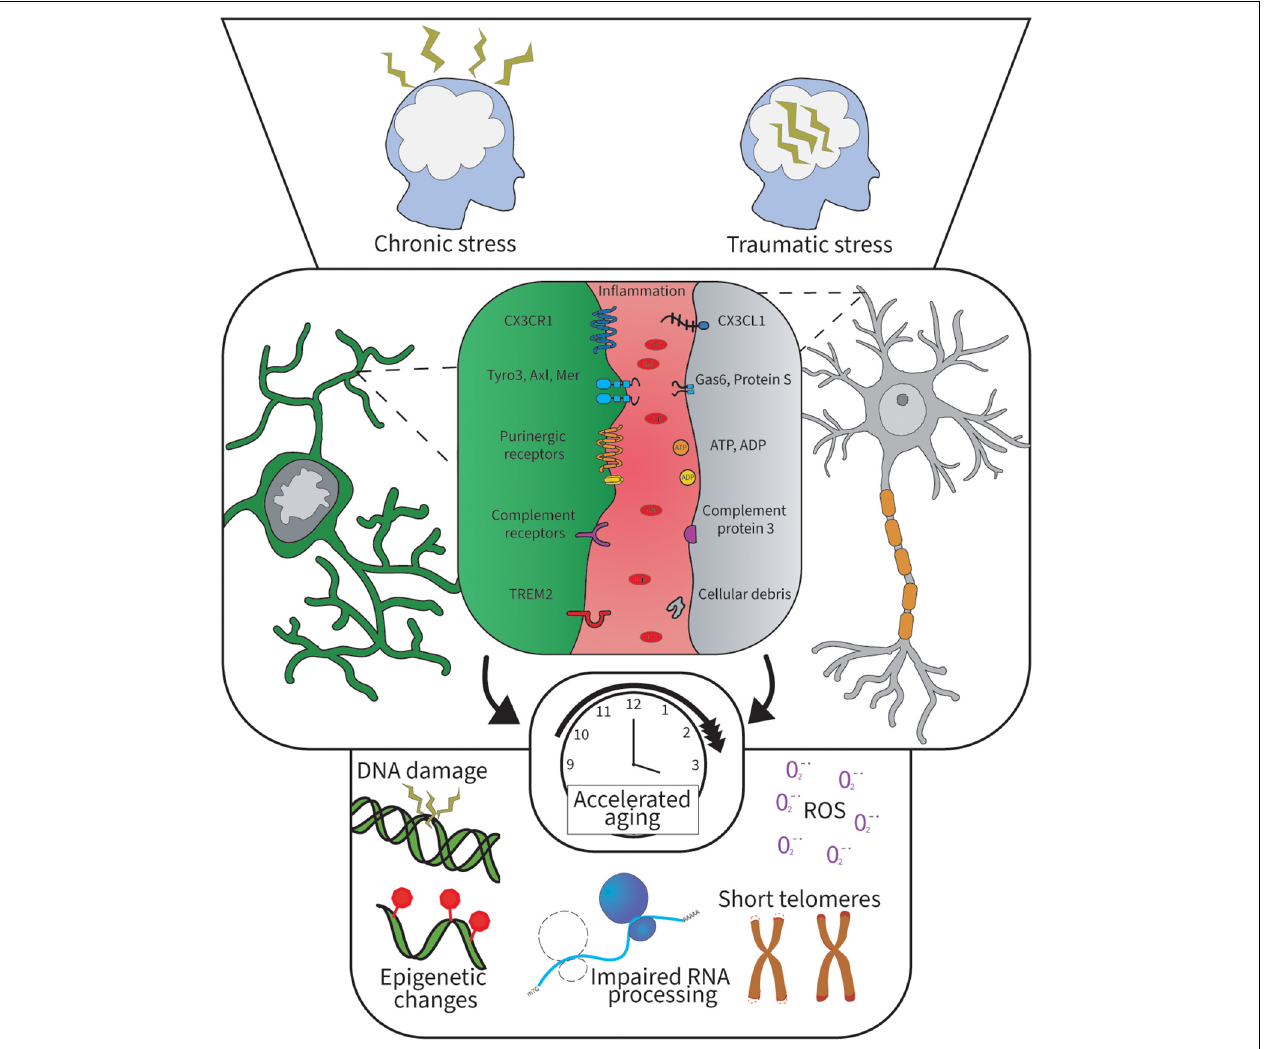
FIGURE 1 | Psychological stress and inflammation alter microglia-neuron communication and lead to cellular aging. Psychological stress induces brain inflammation and oxidative stress resulting in cellular aging when prolonged. This hostile brain environment disrupts the microglia-neuron brain communication and leads to cognitive decline. The top panel illustrates two major types of stress lived by humans. The middle panel shows the different microglia-neuron signaling pathways in the brain and the key inflammatory factors identified in chronic stress. The bottom panel illustrates the different cellular aging processes happening when cells undergo cellular aging, which is often associated with inflammation and